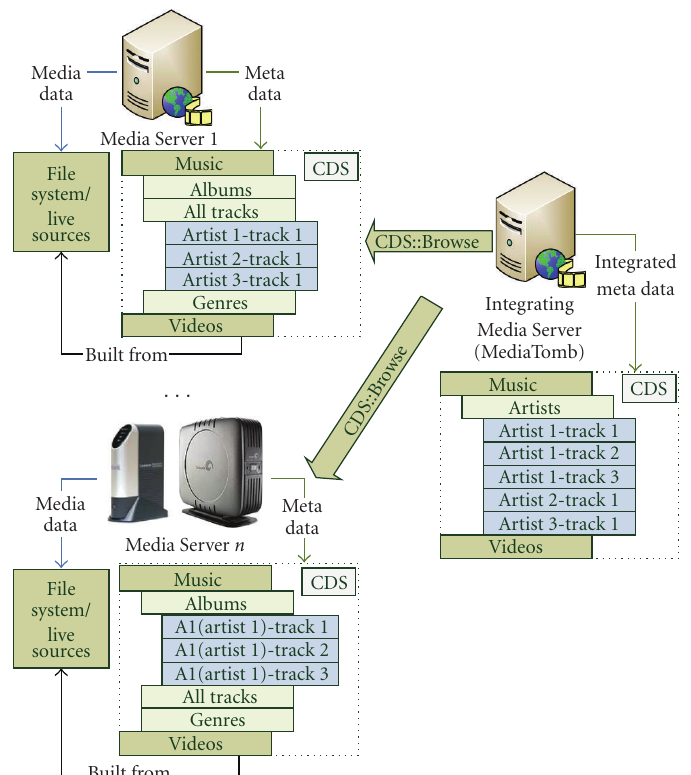
Figure 3: Metadata integration from UPnP-AV Media Servers.